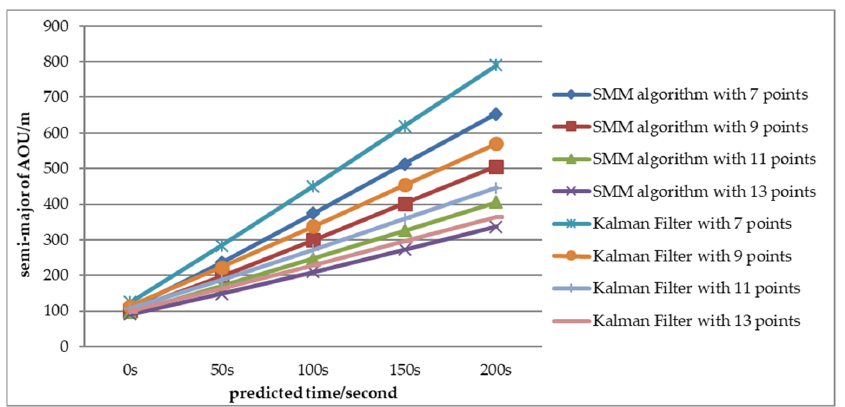
Figure 16. AOU semi-major comparison between the SMM algorithm and the adaptive Kalman filter ( P e = P e 4 ).